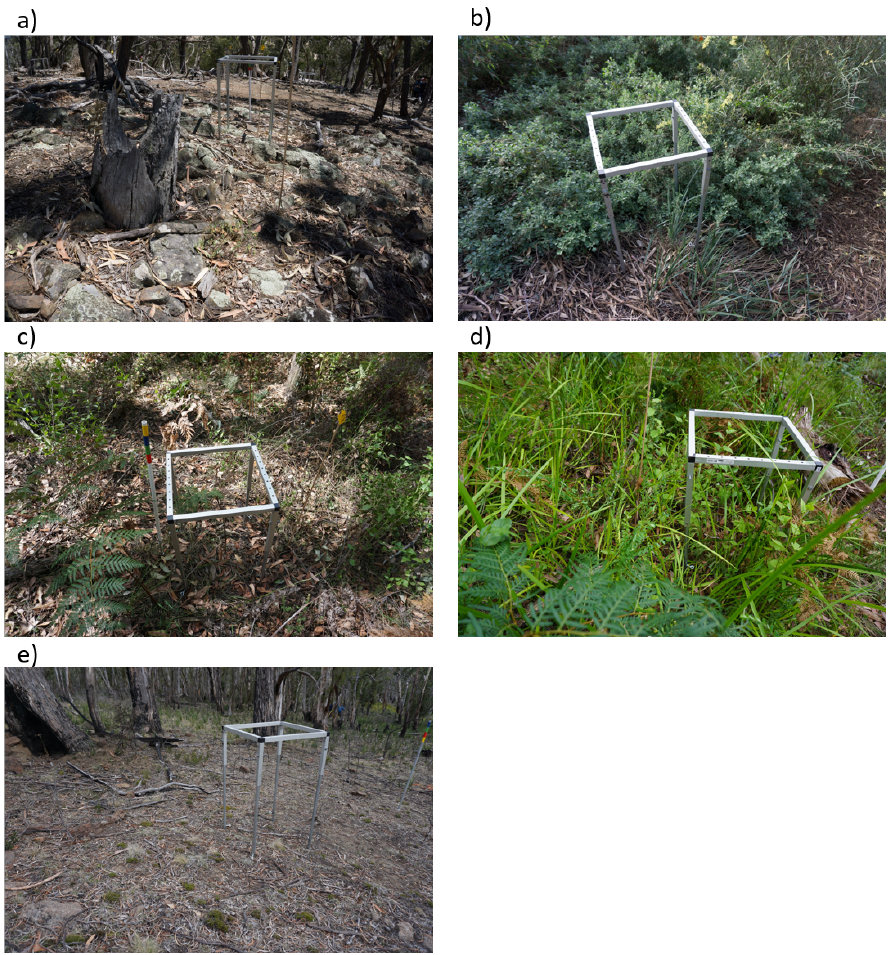
Figure 2. Validation frame was tested in a variety of landscapes ranging in height and cover: ( a ) High Camp, Victoria, Australia; ( b ) Royal Park, Victoria, Australia; ( c ) Silvan1, Victoria, Australia; ( d ) Silvan2, Victoria, Australia; and ( e ) Ridgeway, Tasmania,